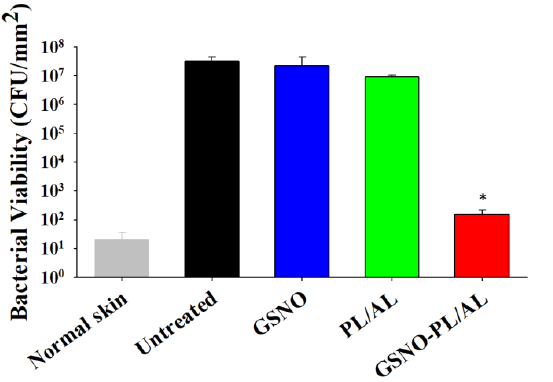
Figure 7. Bacterial burden in wounds at 11 days after injury. * p < 0.05 vs. untreated.